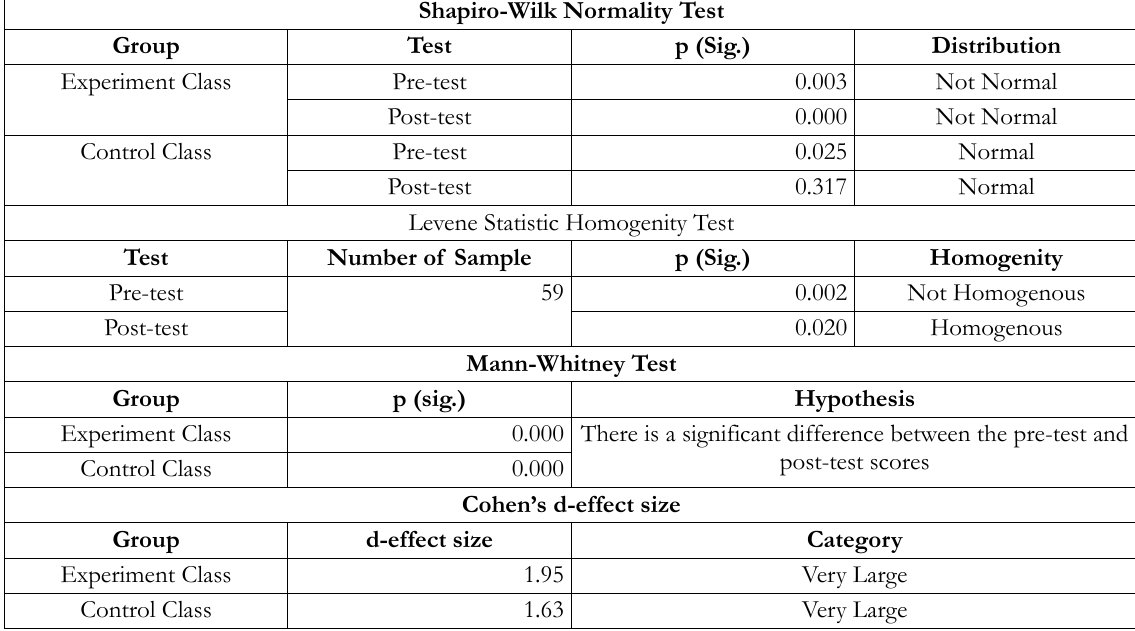
Table 6. The test results of Shapiro-Wilk normality, Levene statistic